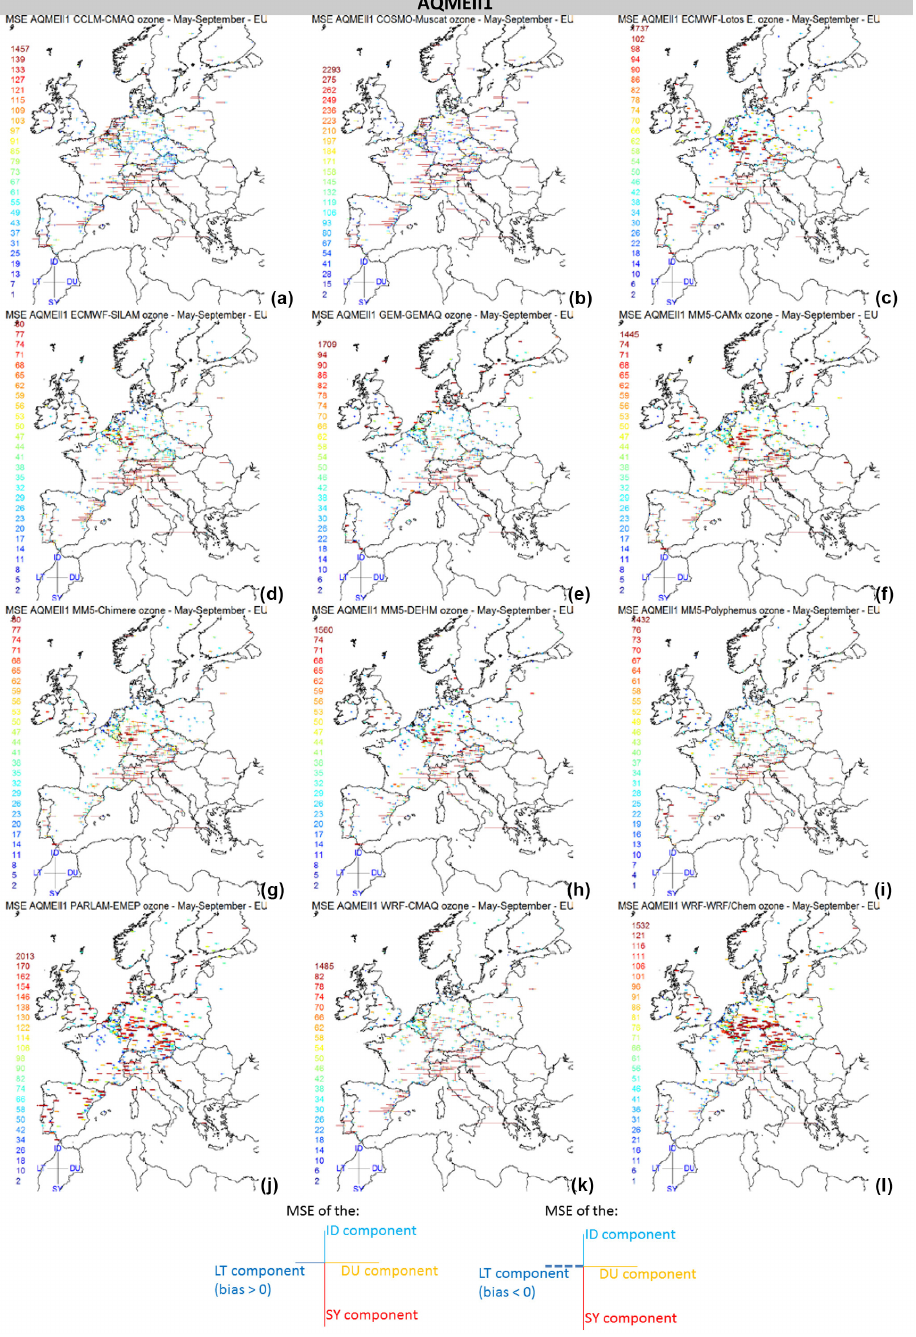
Figure 3. Spatial distribution of the MSE in the spectral components for the EU models of AQMEII1. The segments are centred at the rural receptors’ position (clockwise from north: MSE of ID, DU, SY, and LT). Their length is proportional to the MSE magnitude, coded according to the colour scale. For each model, the colour scale extends from zero up to the 75th percentile, and the last value of the scale is the maximum MSE. The colour of the MSE values above the 75th percentile represents the maximum value. The tick-dashed LT segment indicates model underestimation (low model bias), while thin continuous segment indicates model overestimation (high model bias). The example in the last panel indicates how the maps reports the error of the spectral components at each receptor (the colours are arbitrary). The example on the left represents the error at a receptor where the LT component is biased high, while the example on the right refers to a case where the bias is negative. The other components do not